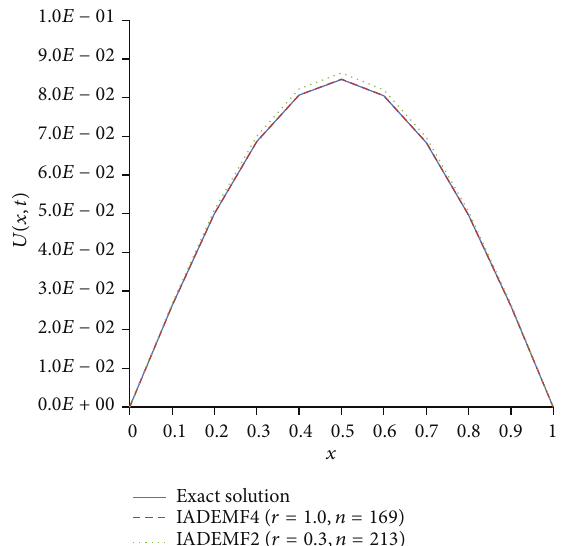
Table 2: Experiment 1. 𝑚 = 700 , 𝜆 = 0.5 , Δ𝑥 = 1.43 × 10 −3 , Δ𝑡 = 1.02 × 10 −6 , 𝑡 = 5.09 × 10 −5 , and 𝜀 = 10 −6 .